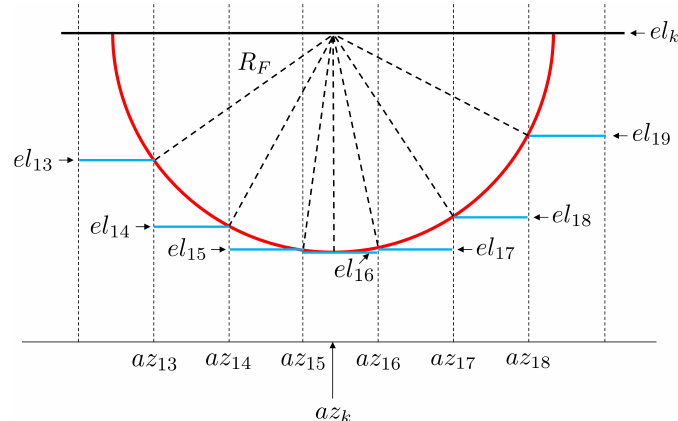
Figure 13. Enlarged display of the Fresnel zone and azimuth cell grid from Figure 12. The blue lines denote the elevation angles for the intersection points of the Fresnel zone boundary (red line) and cell borders (vertical dotted lines). The satellite azimuth angle is denoted by az k , and R F denotes the Fresnel zone